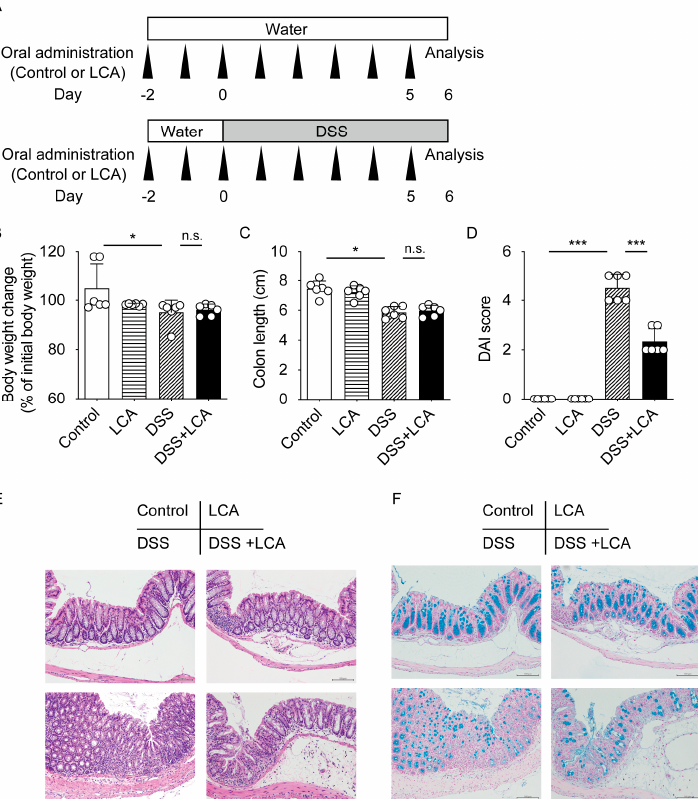
Figure 2. Oral administration of LCA suppresses histological injury in an early phase of DSS-induced colitis. ( A ) Experimental procedure for the assessment of the effect of oral LCA in an early phase of DSS-induced colitis. Mice were subjected to analysis at day 6. n = 6 for each group. ( B ) Body weight change. ( C ) Colon length. ( D ) DAI score. Data are presented as means ± S.D. * p < 0.05; *** p < 0.001; n.s., not significant (one-way ANOVA followed by Tukey’s multiple comparisons). ( E ) Histology with hematoxylin and eosin staining. ( F ) Histology with Alcian blue staining. Scale bar, 100 μ m. Original magnification 200×.